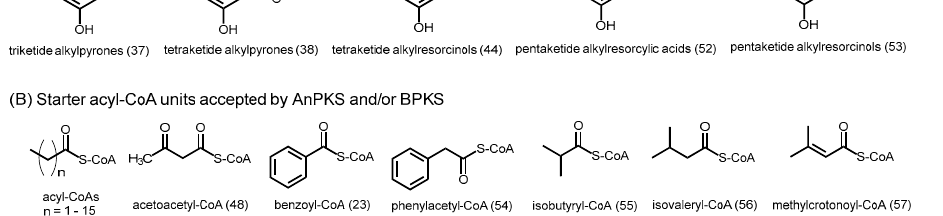
Figure 15. Substrate and product profiles of A. niger AnPKS and B. cinerea BPKS. ( A ) Products formed, and ( B ) starter acyl-CoAs accepted by the enzyme.